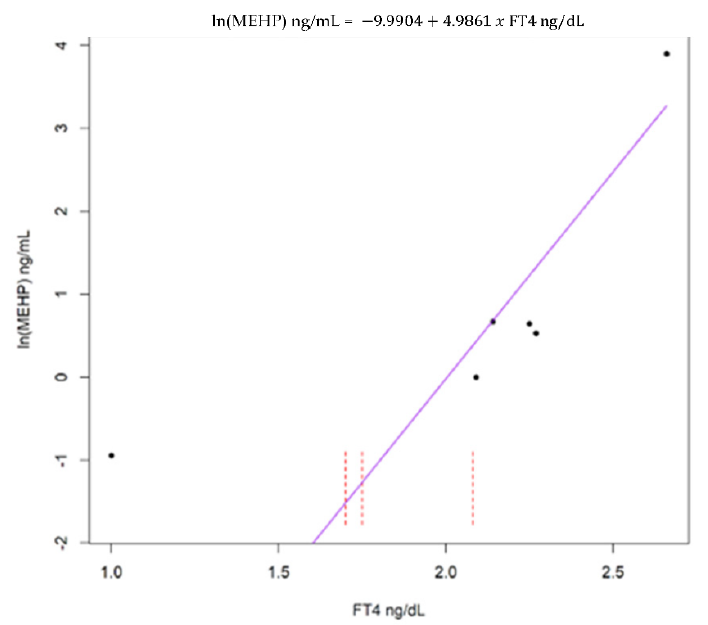
Figure 2. Akritas–Theil–Sen (ATS) line for the relationship between adult male free thyroxine (FT4) and natural log transformed mono(2 ‐ ethylhexyl) phthalate (MEHP). Kendall’s tau = 0.42, p = 0.02. Dashed red lines represent intervals for censored values below the limit of detection.